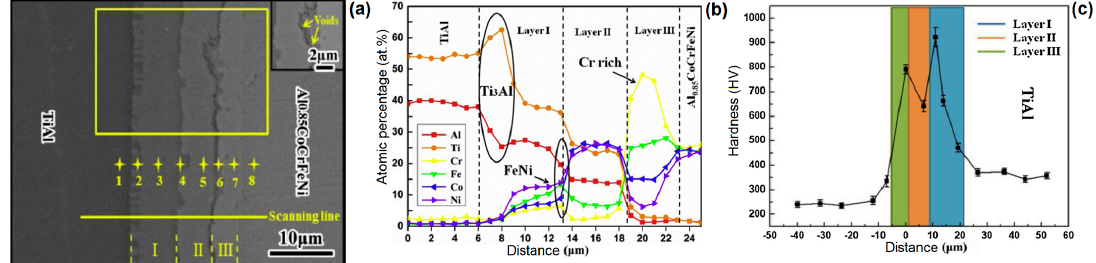
Figure 5. Typical insterfacial microstructure of a dissimilar diffusion bonding ( a ), compositional elemental distribution through the graded microstructura ( b ), and measured Vickers hardness in the different layers that formed the welded joint. Adapted from